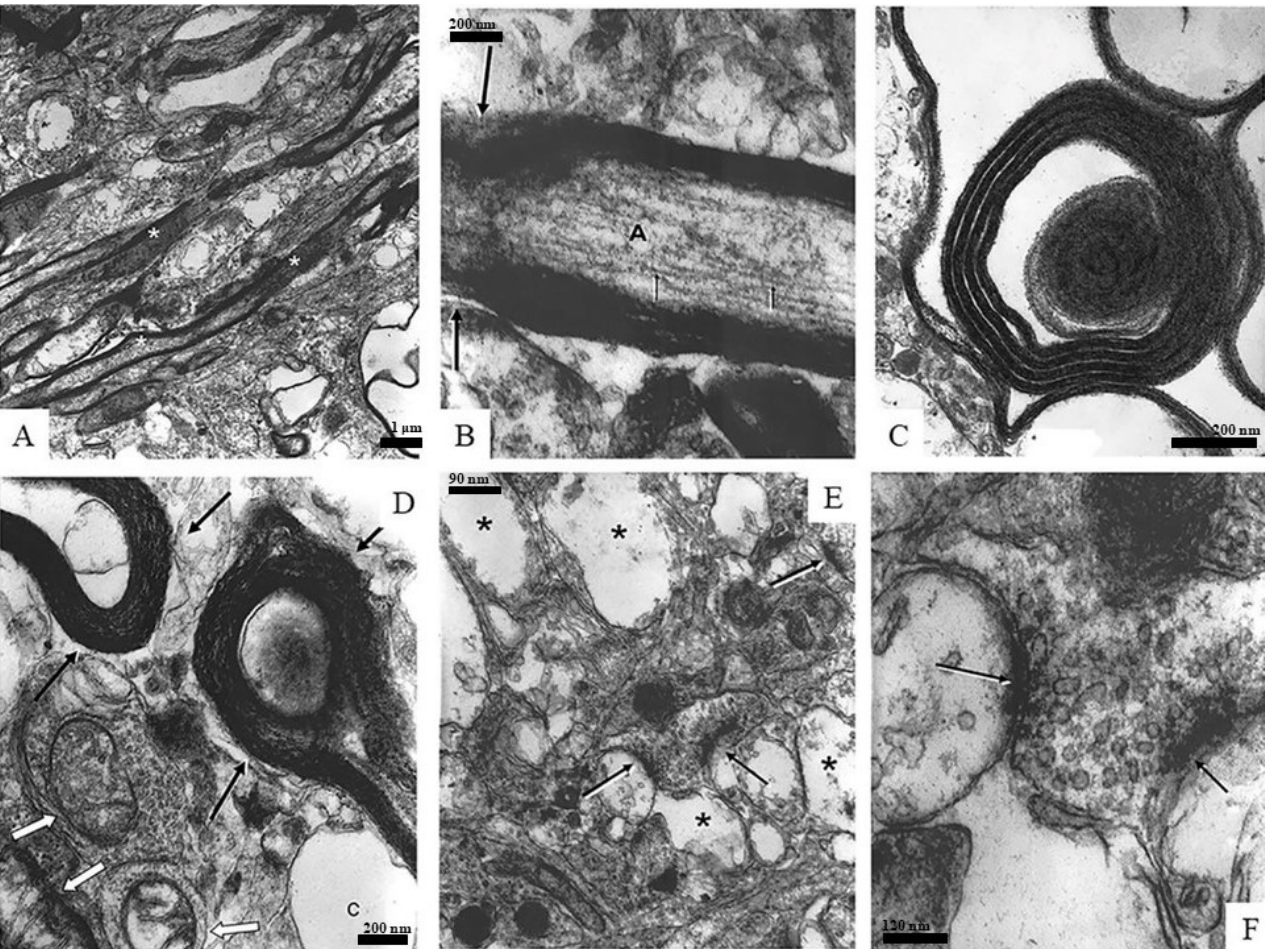
Figure 4. Panel of images depicting different samples of neuronal components found in the spongi- form neuropil, such as myelinated axons, synapses, and mitochondria. ( A ) shows healthy, myelinated axons (asterisk). ( B ) is a high-magnification image of ( A ), in which axoplasm (A) and axonal neurofilaments (arrows) can be easily recognized. ( C ) shows an image where both the axon and tissue surrounding the myelin sheath are deteriorating or are completely missing, while the myelin seems to be intact. The myelin in ( D ) also displays a healthy appearance while the axoplasm of the axons (black arrows) is nearly completely degraded. Cisternae (c) as well as mitochondria (white arrows) can also be seen. ( E , F ) focus on surviving synaptic elements (arrows). ( E ) depicts these syn- aptic elements among degenerative tissue (asterisks). ( F ) is an enlargement of the two synapses seen in the center of ( E ).